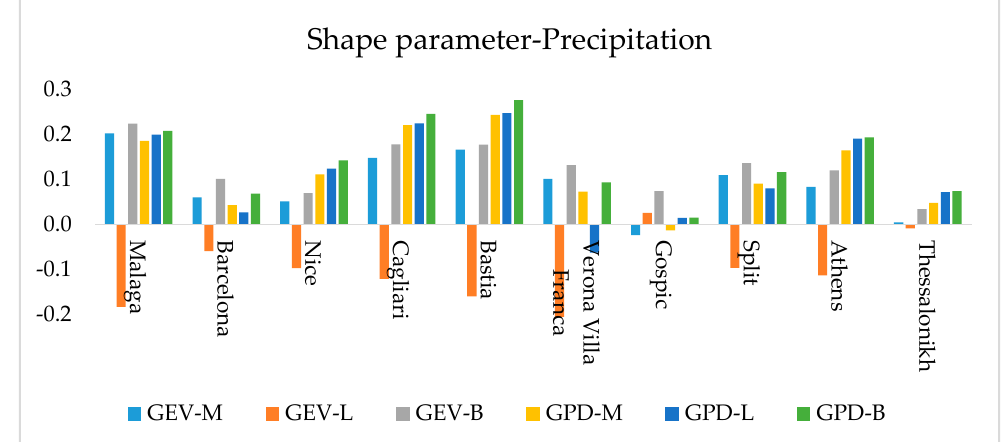
Figure 2. Shape parameter of the 10 studied stations, estimated by six different statistical methods (GEV-M, GEV-L, GEV-B, GPD-M, GPD-L,